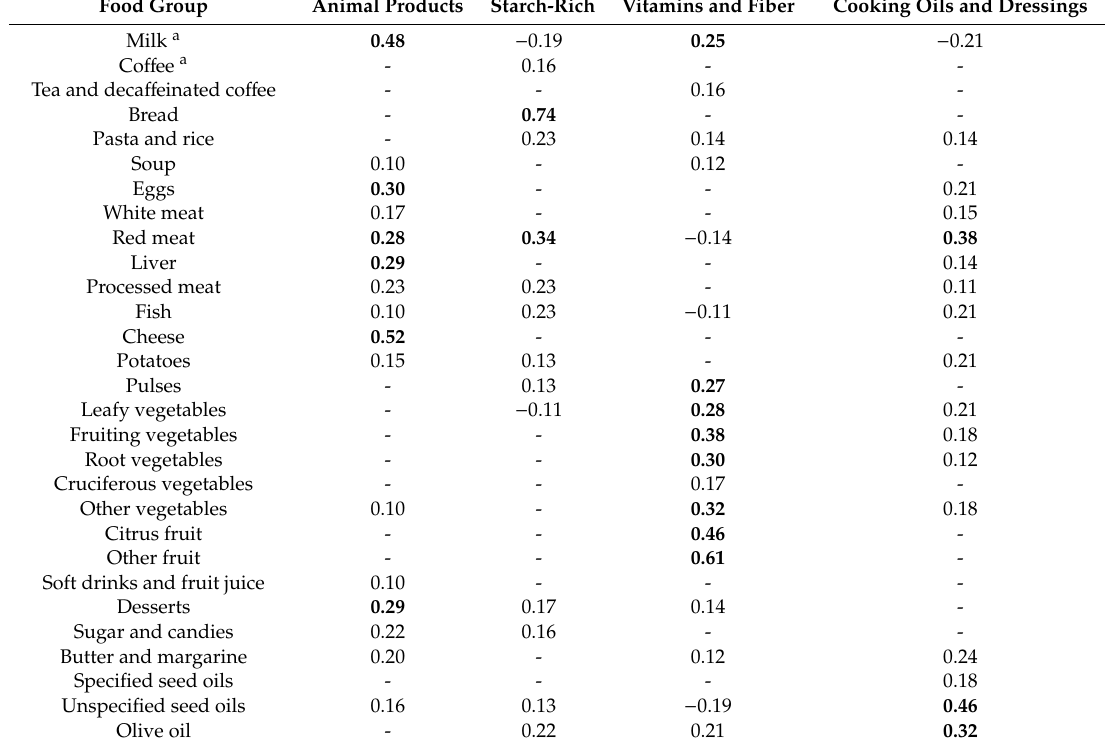
Table 3. Spearman rank correlation coe ffi cients between continuous factor scores derived from factor analysis on nutrient intakes and weekly number of portions for 29 selected food groups defined on the same